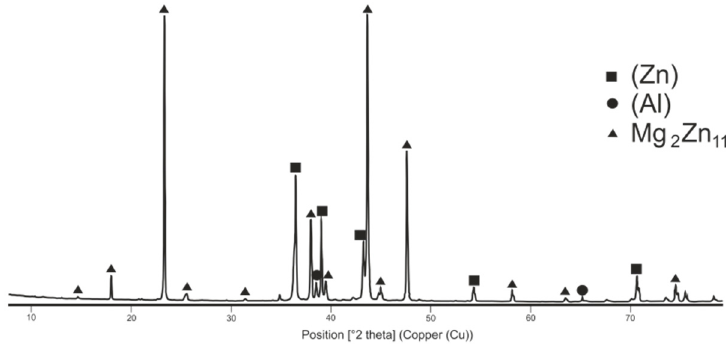
Figure 11. The diffraction record of Zn5Al3Mg solder. Figure 11. The di ff raction record of Zn5Al3Mg